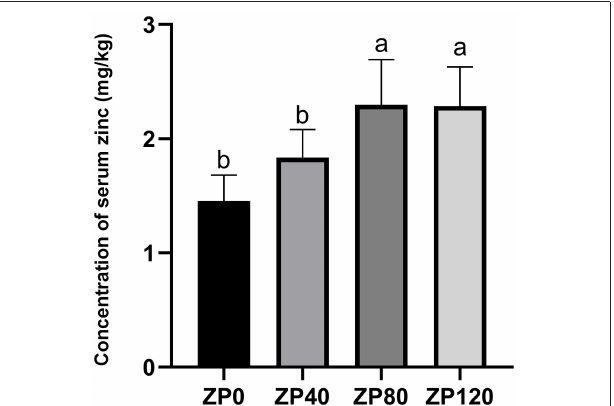
FIGURE 1 | The concentration of serum zinc in dairy cows supplemented with different dose of zinc proteinate on day 14 (Experiment 1). a,b Mean values in the same row with different superscripts are significantly different ( P < 0.01). ZP0, ZP40, ZP80, and ZP120: 0, 40, 80, and 120mg zinc/day of zinc proteinate were supplemented, respectively ( n = 12 per group).